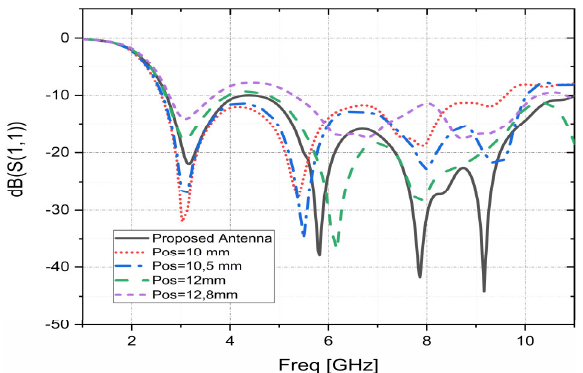
Figure 5. Simulated S11 parameters as functions of “Pos”.